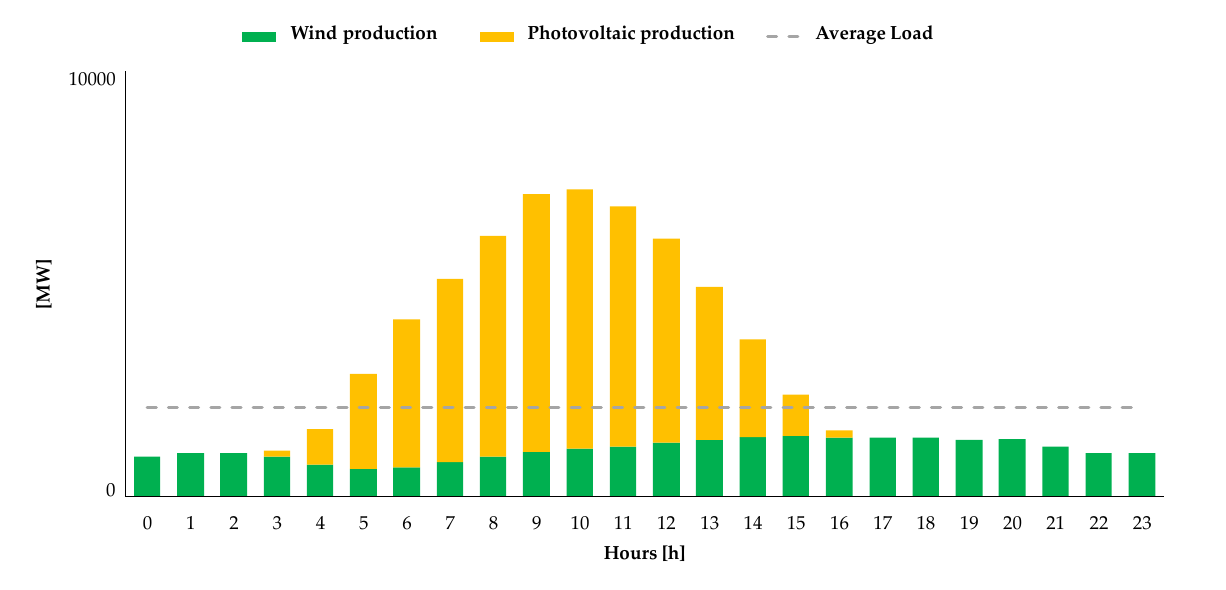
Figure 8. Typical foreseen day profile for Sicily region: wind production, solar photovoltaic produc- tion, and average load. Table 6. Assumptions regarding load value and RES technologies’ producibility values for all areas under study.